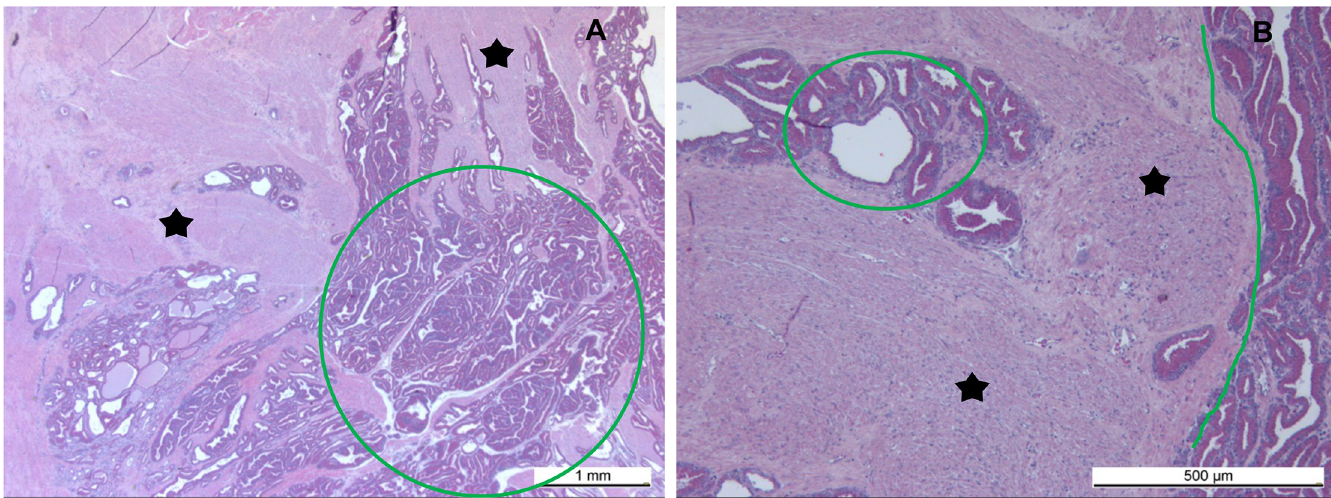
Fig 6. Sections of the prostate (from the whole organ) 11 months after the intraprostatic steam application, (A) an overview of the irregular but sharp transition zone from the steam treated area (black asterisk) to the normal glandular tissue (green oval), (B) higher magnification of the steam-treated glandular tissue, which was replaced by broad, collagen-rich fibrous tissue without any signs of inflammation or necrosis (scar). HE staining , magnification 1 . 25x10 (A) , 5x10 (B) .